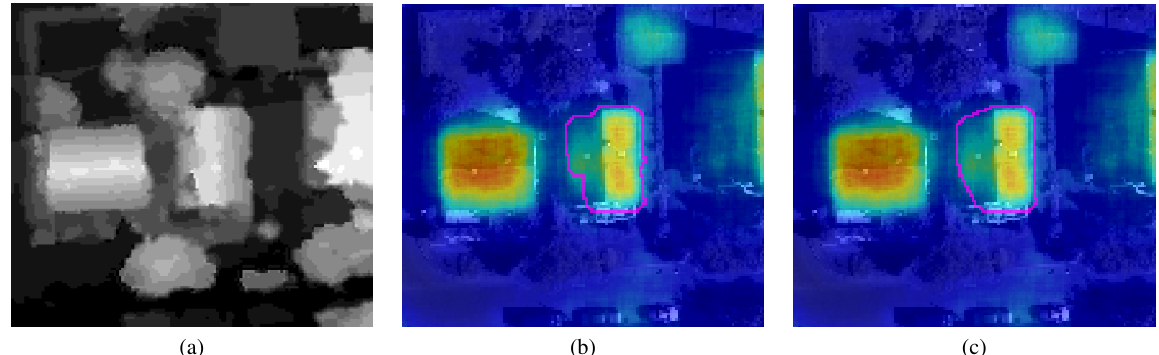
Figure 2. Example of building candidate generation with α -shapes based on (a) the nDSM and (b,c) unary classifier scores (the more red, the higher the building likelihood) with α = 1 at (b) and α = ∞ at (c). to a higher-order clique with a robust P N -Potts potential